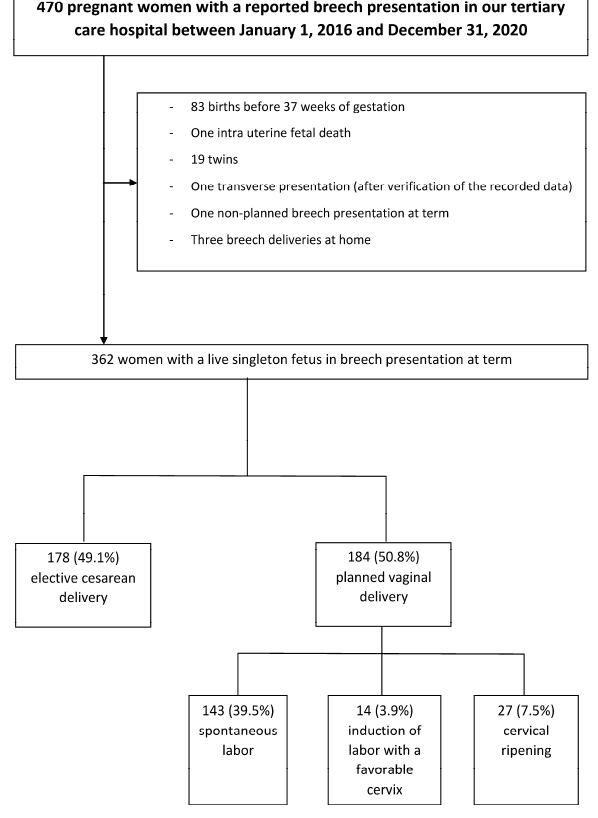
Figure 1. Figure 1. Flow-chart.